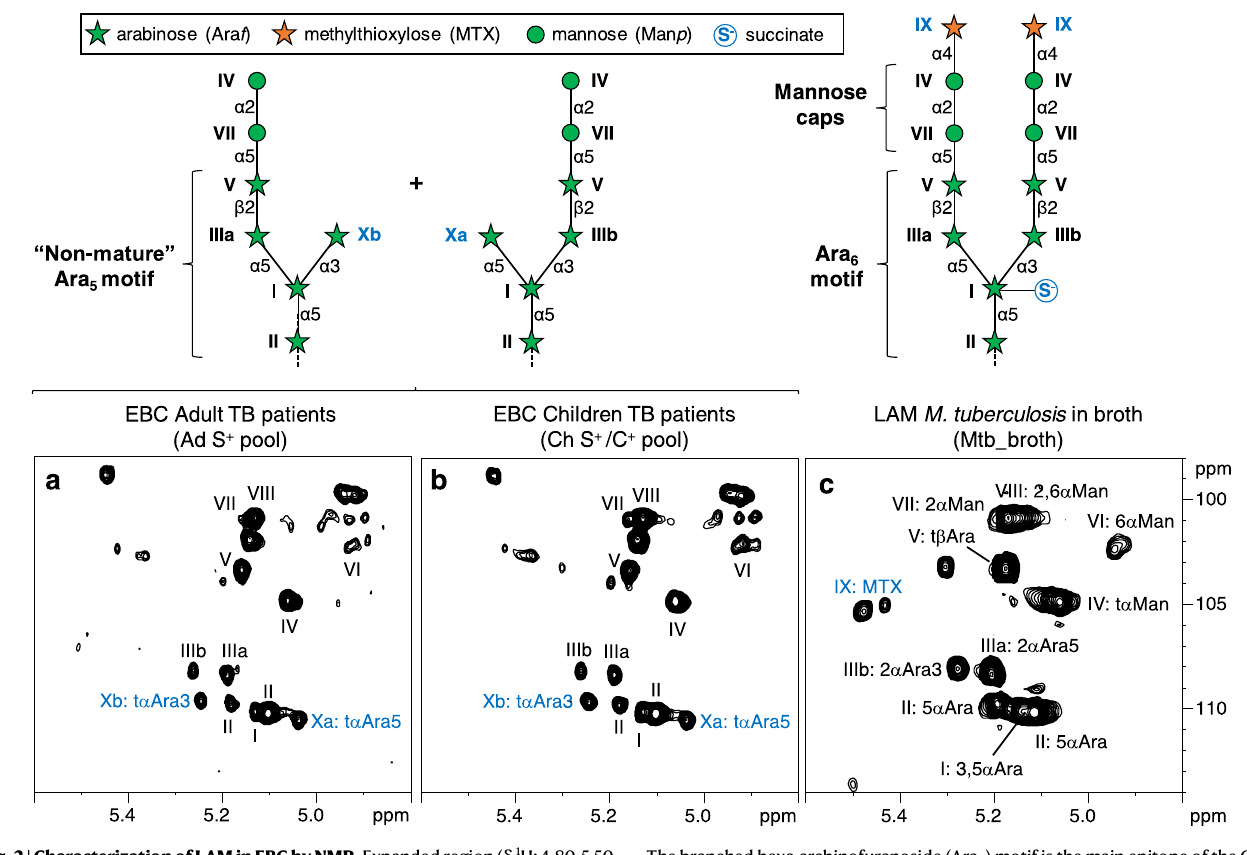
Fig.2|CharacterizationofLAMinEBCbyNMR. Expandedregion( δ 1 H:4.80-5.50, Thebranchedhexa-arabinofuranoside(Ara 6 )motifisthemainepitopeoftheCS-35 δ 13 C 98-114) of the 2D 1 H- 13 C HSQC spectrum in D anti-LAM antibody. Structural motifs that differ between LAM in EBC and LAM 2 O at 298K of Ad S + pool ( a ) and puri fi ed from M. tuberculosis H37Rv grown in broth are highlighted in Ch S + /C + pool ( b ) LAM-enriched fractions, and Mtb_broth LAM ( c ). Cartoons show the structure of arabinan side chain termini deducted from NMR data.